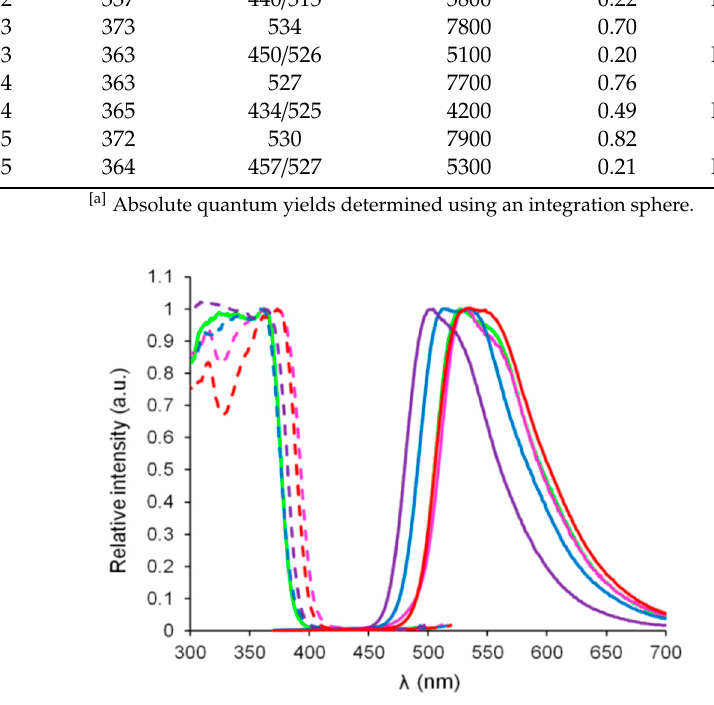
Figure 5. Excitation (dotted line) and emission (plain lines) spectra of HBO dyes 1 (purple), 2 (blue), 3 (red), 4 (green), and 5 (pink) in the solid-state as embedded in KBr pellets (concentration around 10 − 6 M).